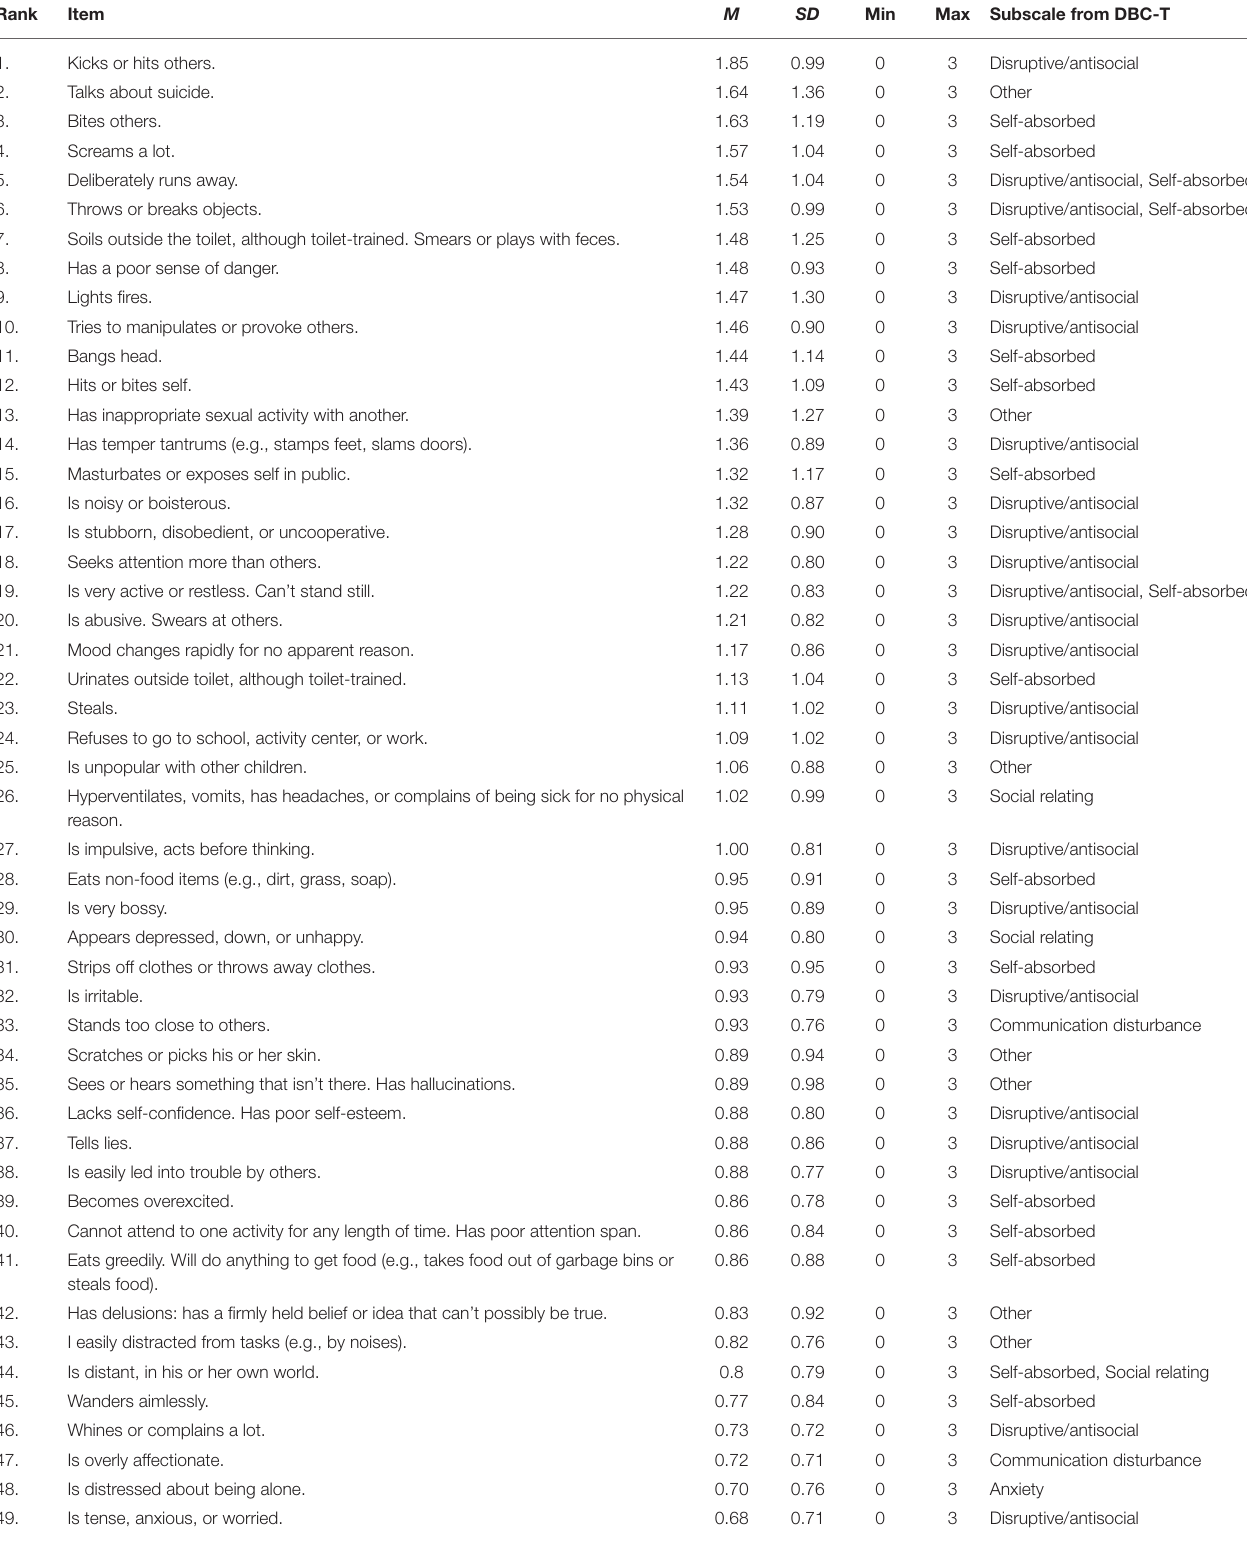
TABLE 1 | Item means and distributions of perceived stress due to different student problem behaviors in ranked order. Rank Item M SD